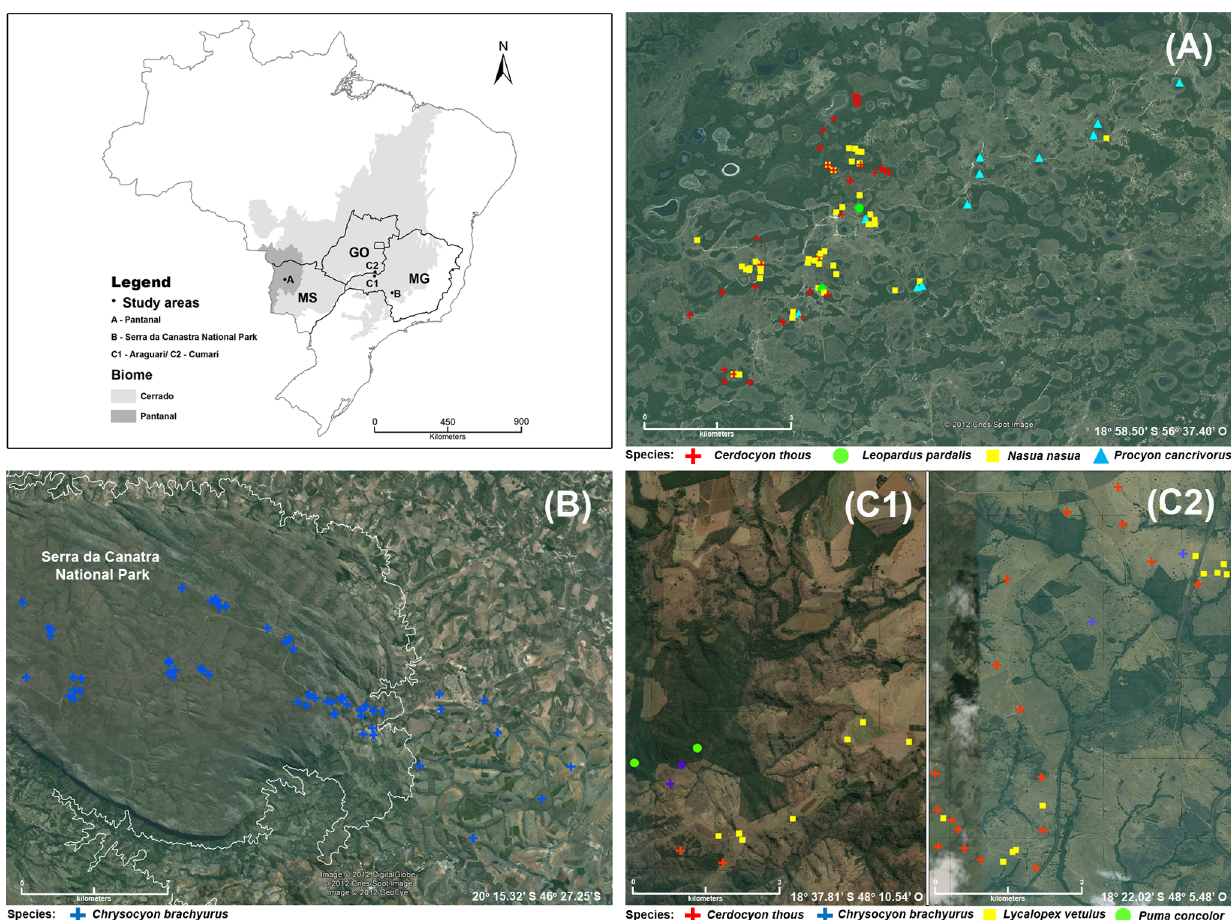
Figure 1. Spatial distribution of free-ranging carnivore species examined for Trypanosomacruzi infection in Brazil. (A) Pantanal - Mato Grosso do Sul State (MS), (B) Serra da Canastra National Park (SCNP) and its surroundings - Minas Gerais State (MG), (C1) Araguari – Minas Gerais State (MG) and (C2) Cumari – Goia´s State (GO). Geometric symbols represent carnivore species, according to the figure legend. In the upper left figure the black contour shows the study sites within respective States in Brazil.